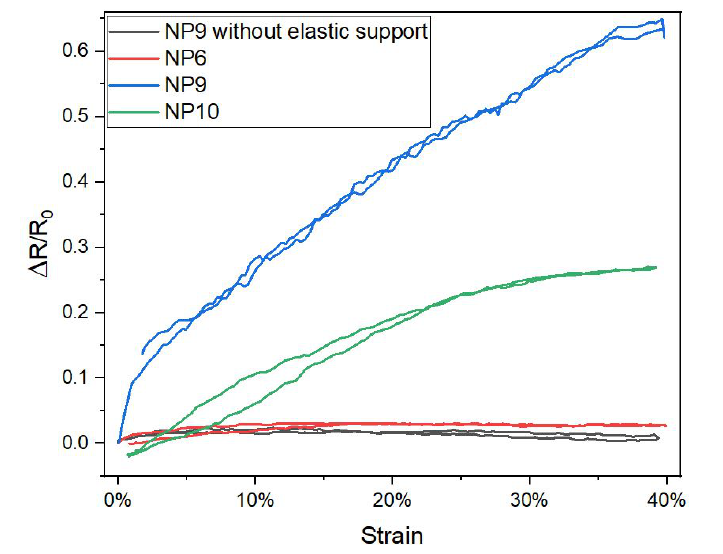
Figure 13. Different graphs showing high and low hysteresis knitted samples; NP 9 Y S 1 C 2 —without E1, with NP 6 , NP 9 and NP 10